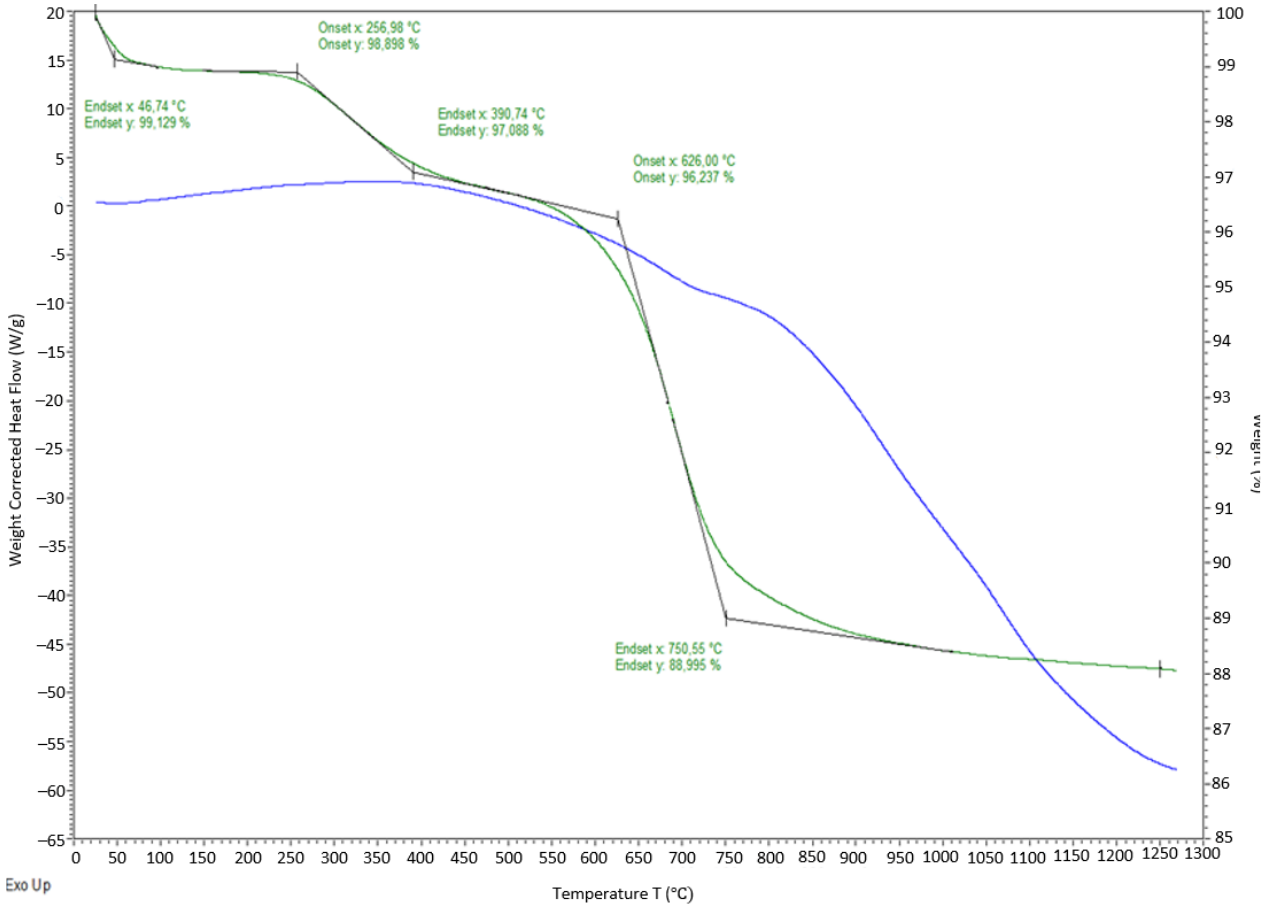
Figure 5. Thermogravimetric analysis of PCS fibers.